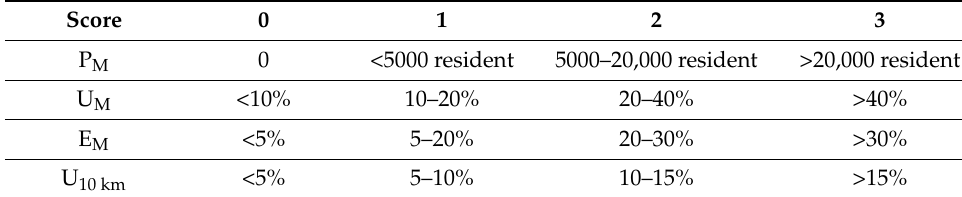
Table 3. Scoring of P M , U M , E M and U 10km .